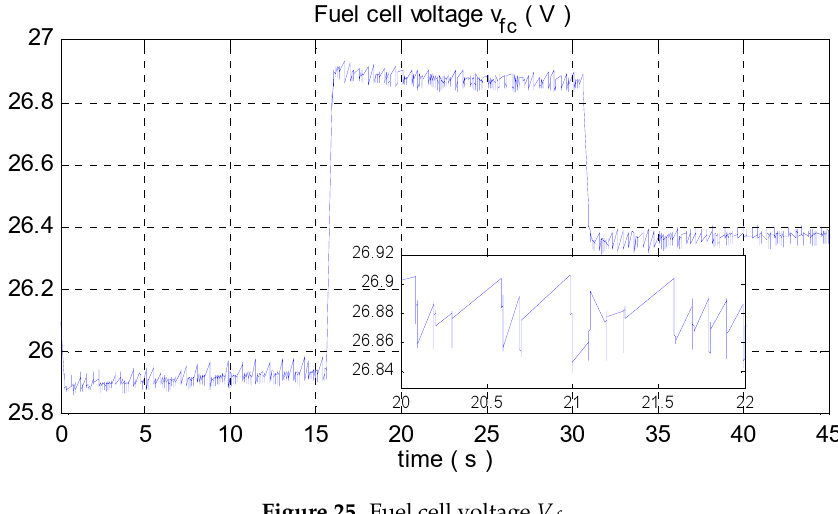
Figure 24. Inductance current